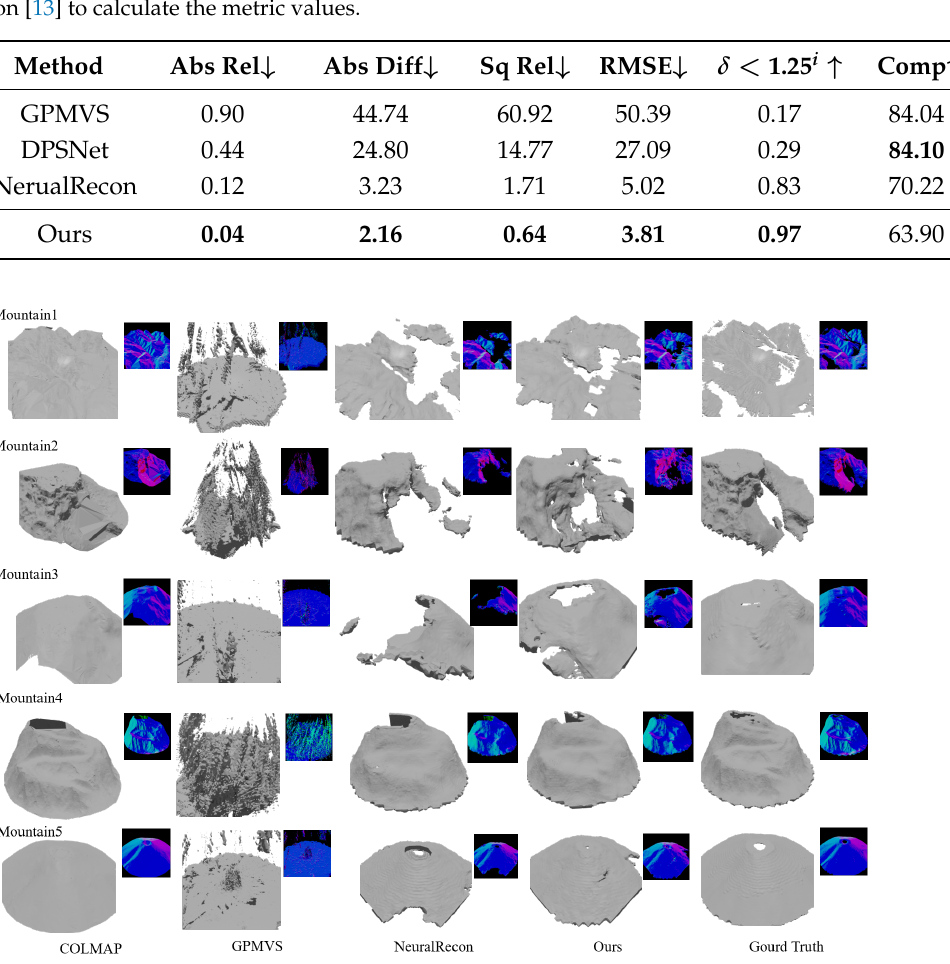
Figure 8. Qualitative results on our dataset. Compared to GPMVS [25] and NerualRecon [13], our method can produce much more complete reconstruction results. Notice that COLMAP generates single layer results and tends to give over-smooth results (some holes are wrongly